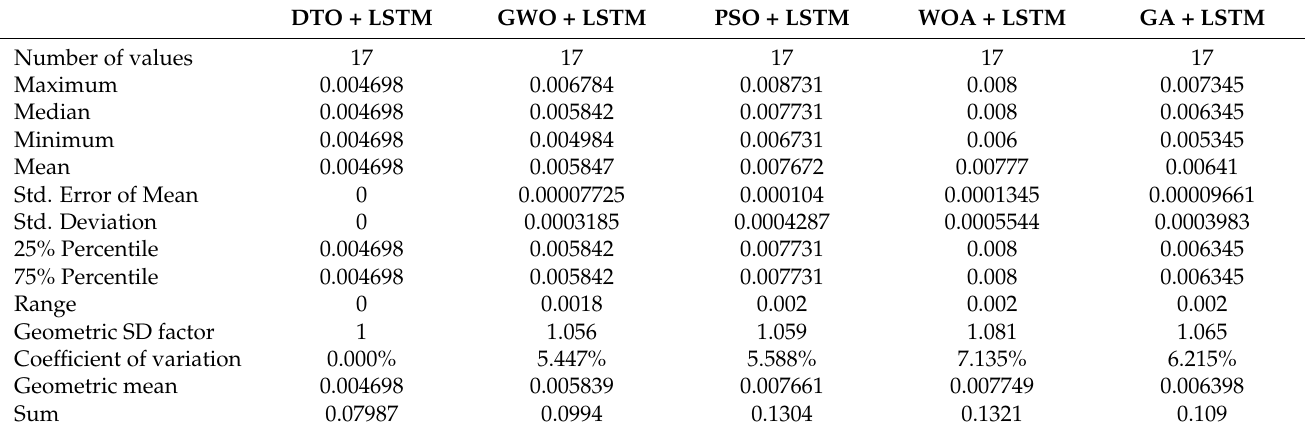
Table 7. Descriptive analysis of the proposed and other competing methods